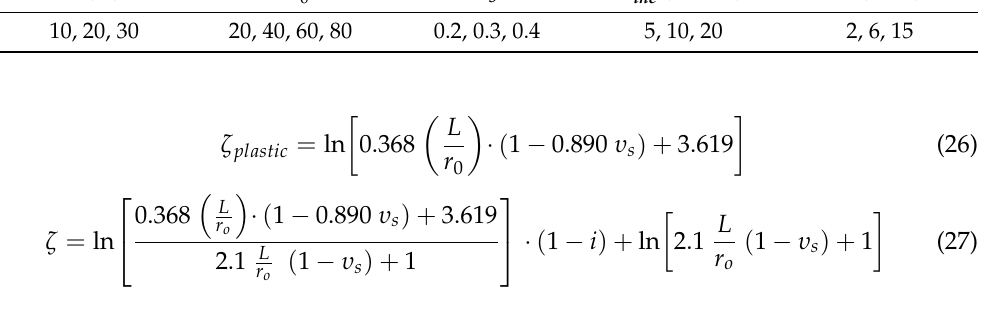
Figure 20. Change of the ζ and r m values as head load increases (slenderness ratio: L soil shear modulus: G = 7962 kPa).